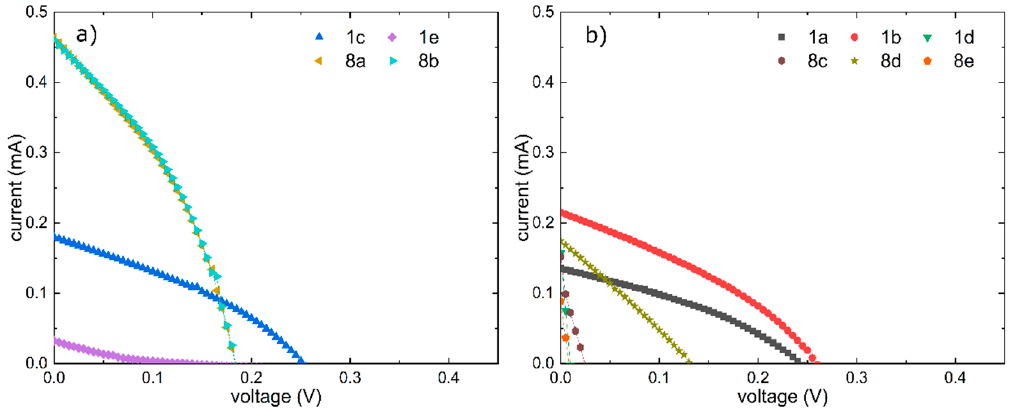
Figure 7. I-V curves of DSSCs from sample 1 and 8 at day 3. The DSSCs considered better in terms of long-term stability are shown in ( a ) and the others in ( b ).